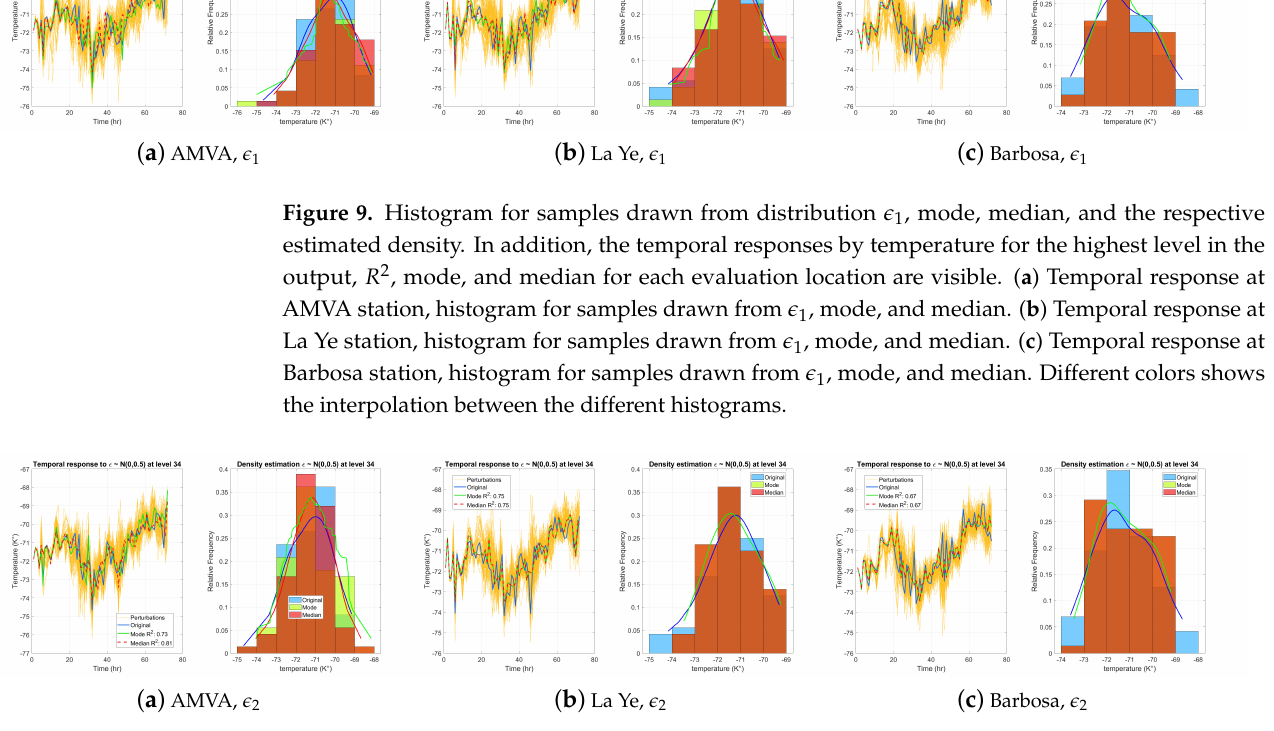
Figure 10. Histogram for samples drawn from distribution (cid:101) 2 , mode and median, and the respective estimated density. Temporal responses by temperature for the highest level in the output, R 2 , mode, and median for each evaluation location. ( a ) Temporal response at AMVA station, histogram for samples drawn from (cid:101) 2 , mode, and median. ( b ) Temporal response at La Ye station, histogram for samples drawn from (cid:101) 2 , mode, and median. ( c ) Temporal response at Barbosa station, histogram for samples drawn from (cid:101) 2 , mode, and median. Different colors shows the interpolation between the different histograms.